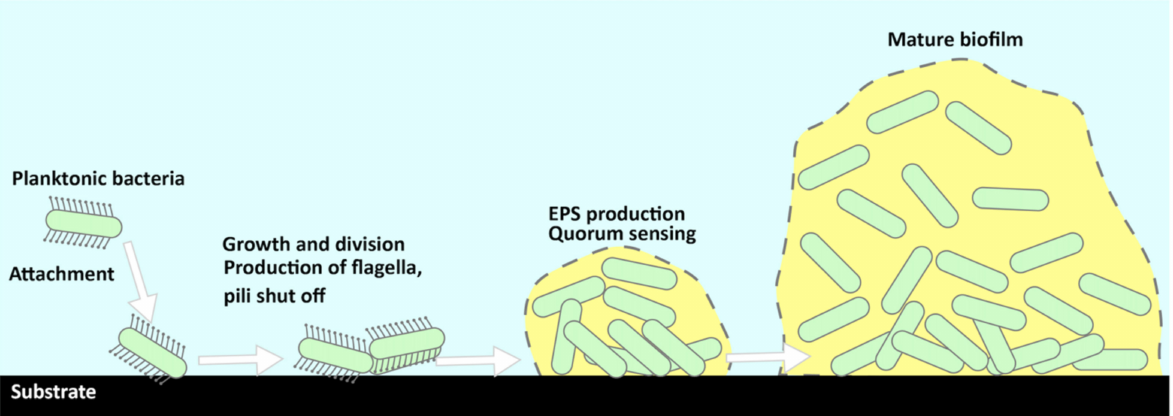
Figure 3. Bacteria attachment on a surface, EPS production, and mature biofilm structure